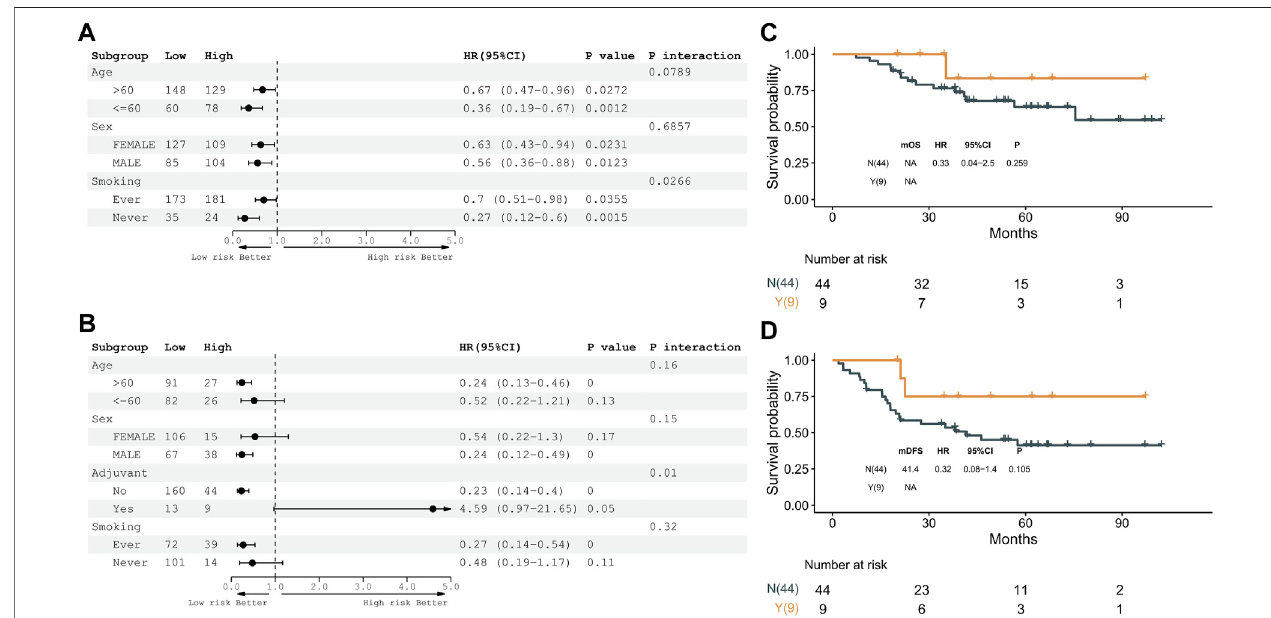
FIGURE 5 | Expression pattern of 16 genes is a prognostic biomarker and predicts adjuvant therapy bene fi ts in the GSE31210 dataset. (A) Subgroup analyses of overall survival to estimate the clinical prognostic value between DRG1 and DRG2 as independent clinical factors. (B) Subgroup analyses of disease-free survival to estimatetheclinicalprognosticvaluebetweenDRG1andDRG2inindependentclinicalfactors. (C) Kaplan – Meiercurvesofoverallsurvivalbetweenpatientstreatedwith or without adjuvant therapy. (D) Kaplan – Meier curves of disease-free survival between patients treated with or without adjuvant